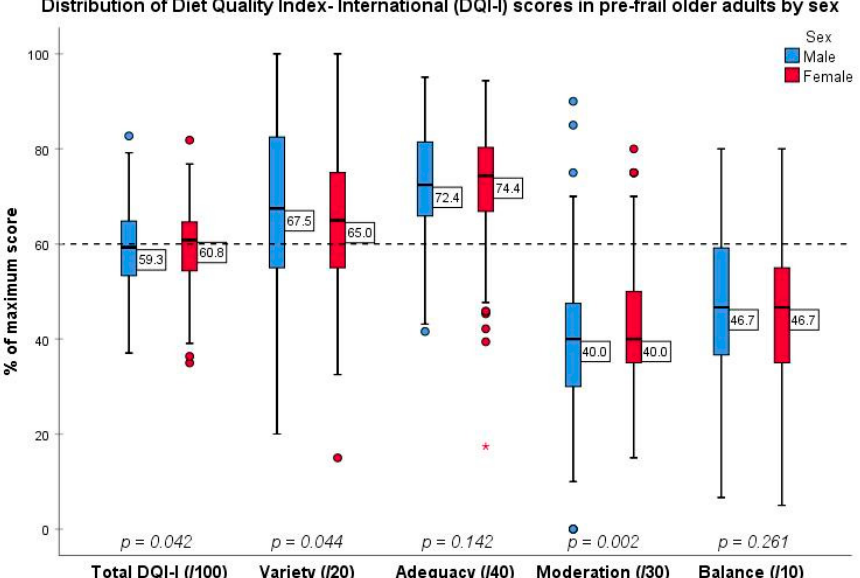
Figure 1. Box and whisker plot depicting DQI-I score attainment according to sex. p -values derived from non-parametric samples tests. The p -value for Balance score was derived by independent samples t -test. Each small circle represents a mild outlier to the data. The asterisk (*) represents an extreme outlier where a participant scored 17% of the maximum attainable score in adequacy.